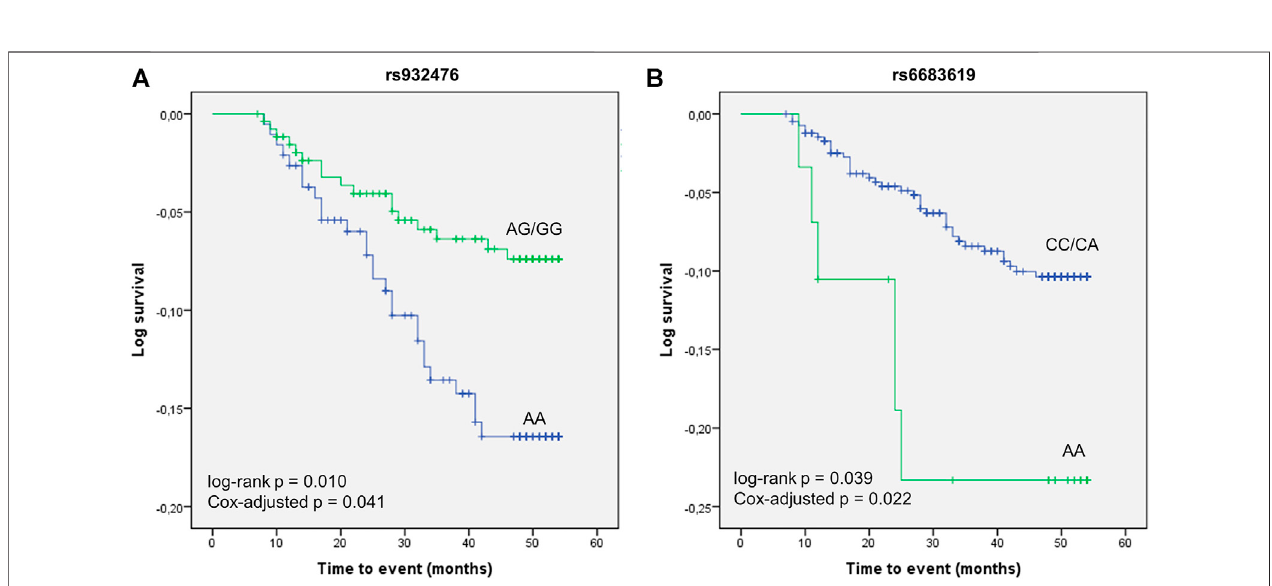
FIGURE 4 | Kaplan-Meier curves of the association of two PLA2G4A polymorphisms, rs932476 (A) and rs6683619 (B) , with CV event-free survival.